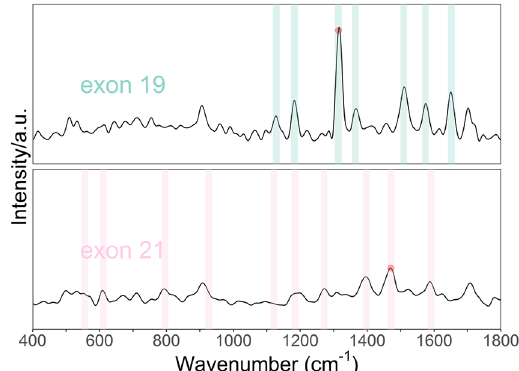
Figure 4. SERS of PCR products of human plasma having mutations at EGFR exon 19 and 21.